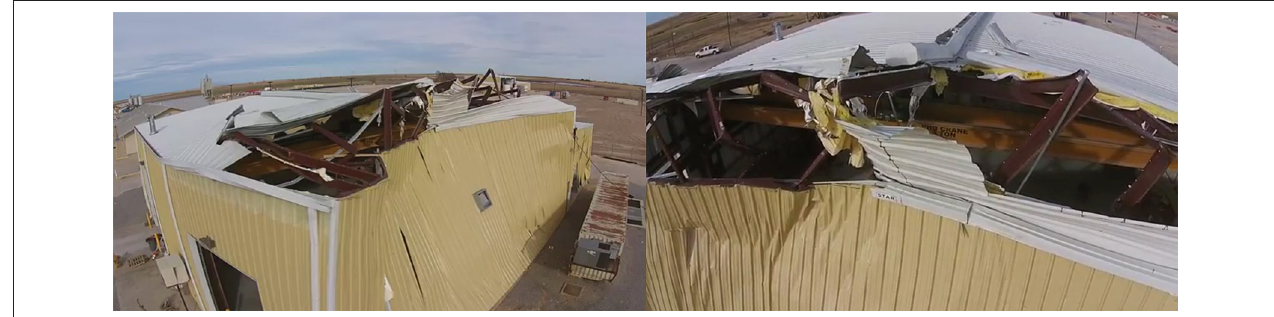
FIGURE 11 | UAS-based imagery of metal building structures damaged by the EF-3 tornado at the Halliburton Oilfield Services facility outside Pampa, TX, in November 2015. (Image Credit: R. L.